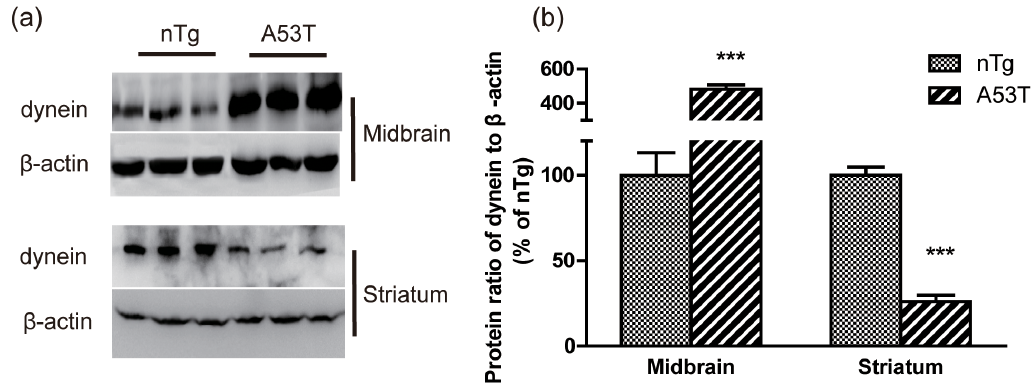
Figure 2. Western blot analyses of dynein in the striatum and midbrain. ( a ) Representative western blot images of dynein and β -actin in the striatum and midbrain are shown, and ( b ) the results were quantified (mean ± SEM) and normalized by the averaged value of nTg group. nTg, n = 5; A53T, n = 8; *** p <0.001 compared to